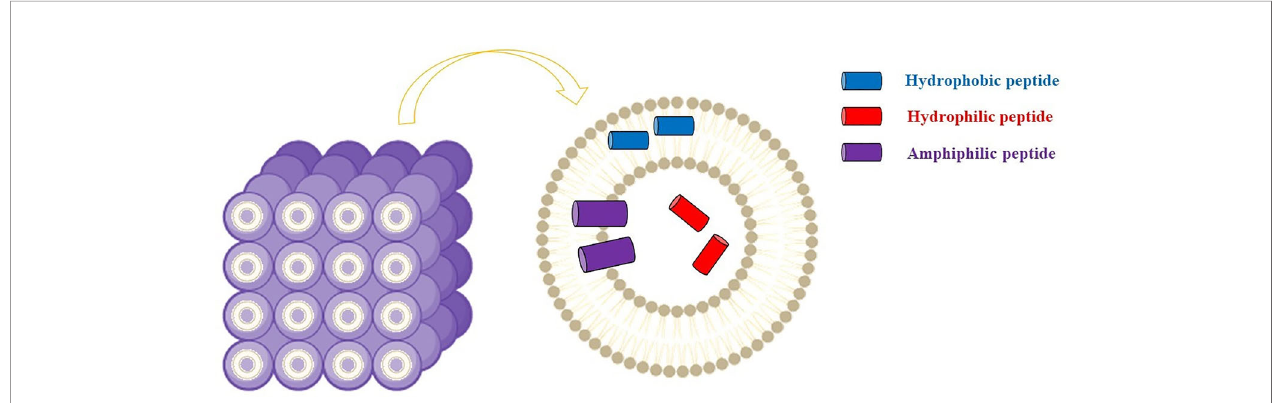
FIGURE 4 | Cubosomes comprise curved lipid bilayers with a well-de fi ned disposition and divided into two internal aqueous channels that can be exploited by antimicrobial peptides. Figure created with